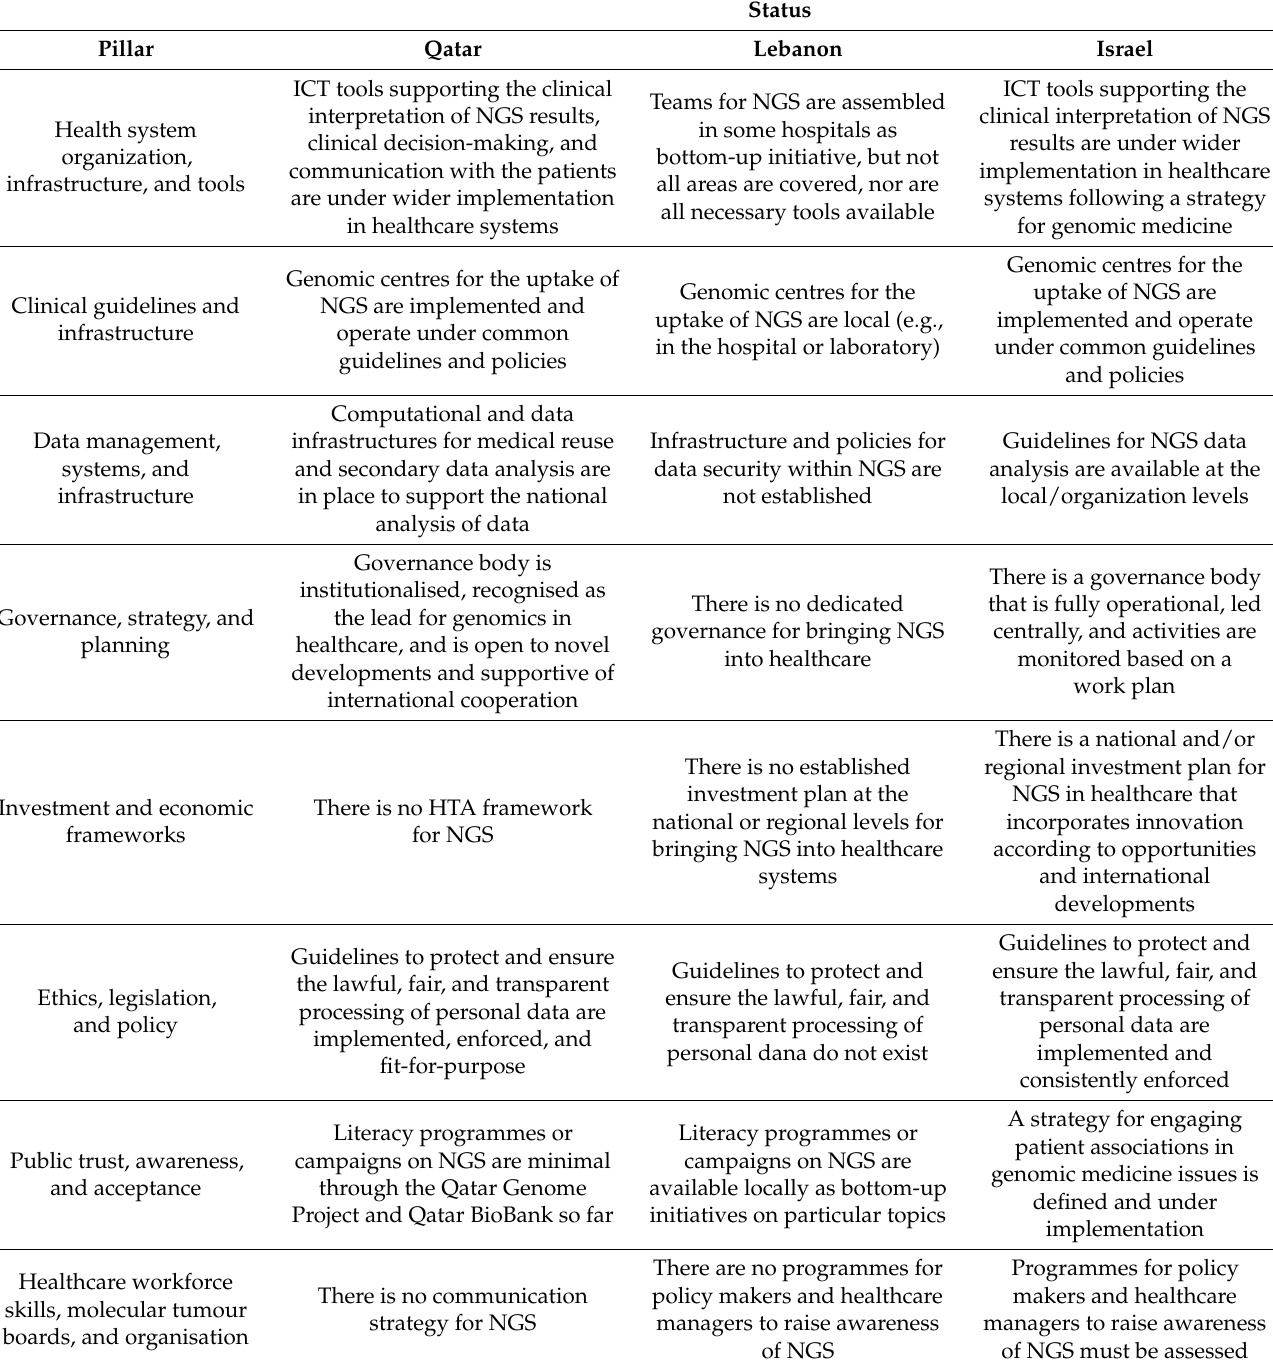
Table A7. Status of NGS maturity levels for a few countries from the Middle